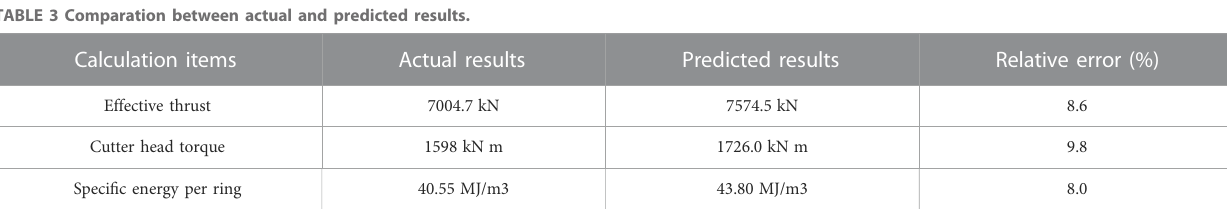
TABLE 3 Comparation between actual and predicted